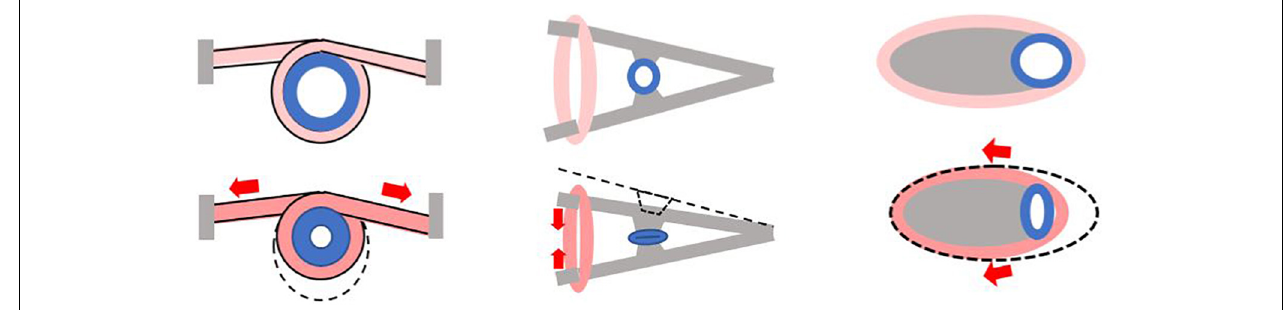
FIGURE 4 | Alternative ways to create a pincher from tissue engineered muscle. Gray color depicts stationary elements that can be created from bone-like or similar material. Pink color indicates tissue engineered muscle. Cross section of the compliant segment of Liebau pump is shown in blue. Each panel shows a pincher before (top) and during (bottom) contraction with red arrows depicting direction of muscle